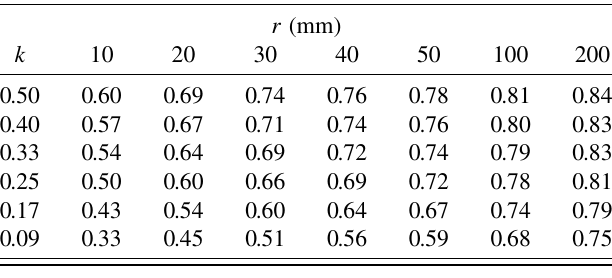
FIG. 15. Ratio between sector width and aperture radius that provides 95% of the maximum critical gradient versus aperture radius for a [0 (cid:9) –24 (cid:9) ,30 (cid:9) –36 (cid:9) ] sector coil.